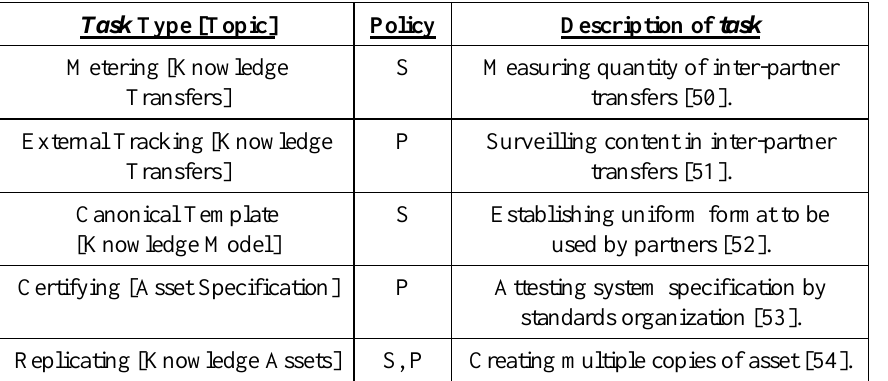
Table 4. Task types and topics in To-Be scenario in Figure